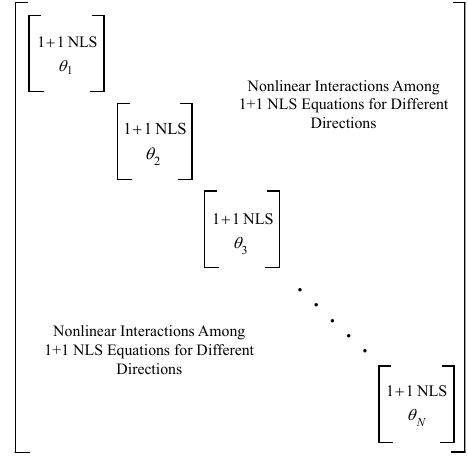
Figure 17. The period matrix for asymptotically solving the 2+1 NLS equation corresponds to diagonal block matrices for each rotated 1+1 NLS equations for each radial direction in the NLFA spectrum. The off ‐ diagonal elements outside these matrices describe the interactions among the directional 1+1 NLS equations on the block diagonal and are assumed to be given by rescaled and rotated forms of the second equation in Equation (147).